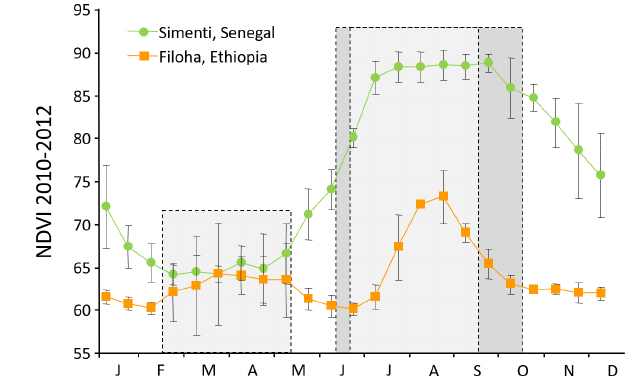
Figure 3. Comparison of monthly normalized difference vegetation indices (NDVI (mean ± SD); measure of “greenness”, i.e. plant pro- ductivity) of the Guinea baboon habitat at Simenti, Senegal, and the hamadryas baboon habitat at Filoha, Ethiopia, for 3 years from 2010 to 2012. Since the NDVI can be regarded as an indirect measure for precipitation, the two periods of rain at Filoha (unpredictable short rains from February to May and long rains from June to September, both light grey) and the one in Simenti (June to October, dark grey) are reflected by respective maxima in the graph (source: MODIS NDVI – MOD44/MYD44 (16d) – TERRA (AM) only; DiMiceli, 2015).